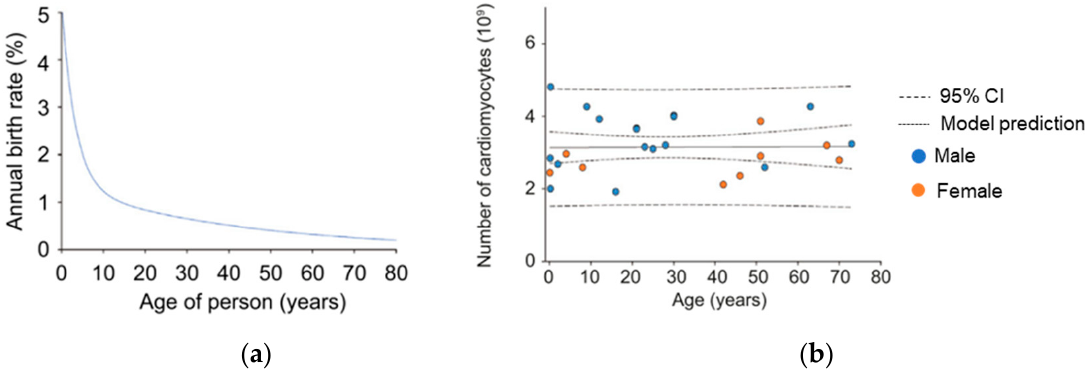
Figure 1. “Regeneration rate and number of cardiomyocytes depending on: ( a ) age and ( b ) gender” Olaf Bergmann et al. [3], licensed under the number 4772391132781.